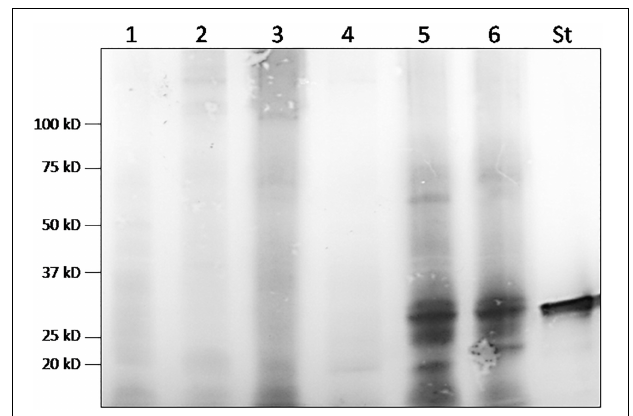
FIGURE 8 | Western-blot analyses of secretions from one N. alata plant inoculated with agroinfiltrated N. benthamiana with empty vector (1 and 4) and from two N. alata plants inoculated with N. benthamiana extract infected by TMV and agroinfiltrated by TMV- (cid:49) CP- gfp (2, 3, 5, and 6) at 5 days (2 and 3) and 14 days (5 and 6) post inoculation (St, GFP